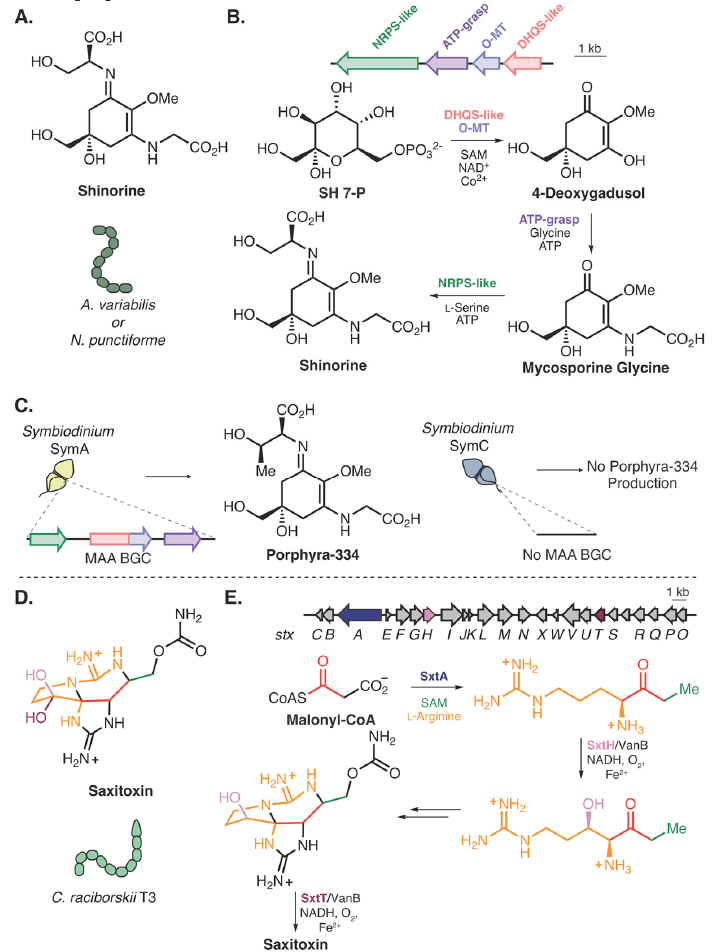
Figure 3. Natural products present in both cyanobacteria and marine eukaryotes. ( A ) Structure of the mycosporine ‐ like amino acid (MAA) shinorine produced by Anabaena variabilis and Nostoc punctiforme . ( B ) Biosynthesis and BGC of shinorine from Anabaena variabilis and Nostoc